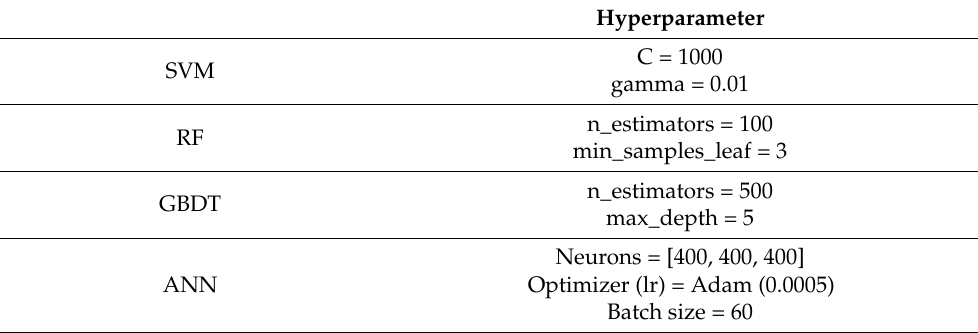
Table 10. Hyperparameter settings of machine learning